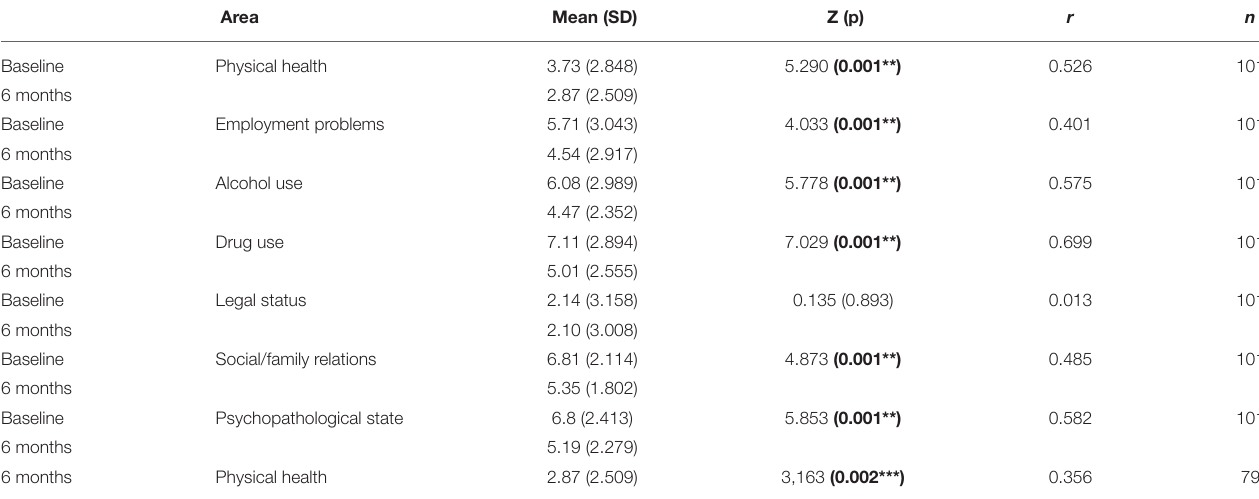
TABLE 3 | Differences between baseline evaluations and 6 months.